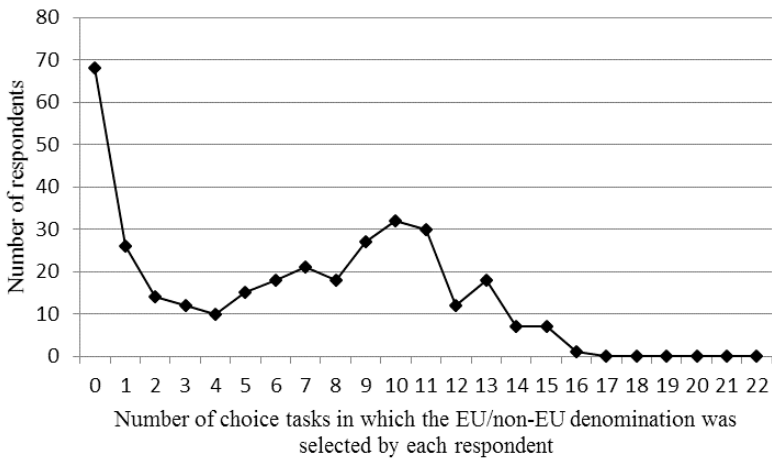
Figure 2. Choice frequency for the EU/non-EU origin denomination within the choice experiment. Each respondent saw 22 choice sets.